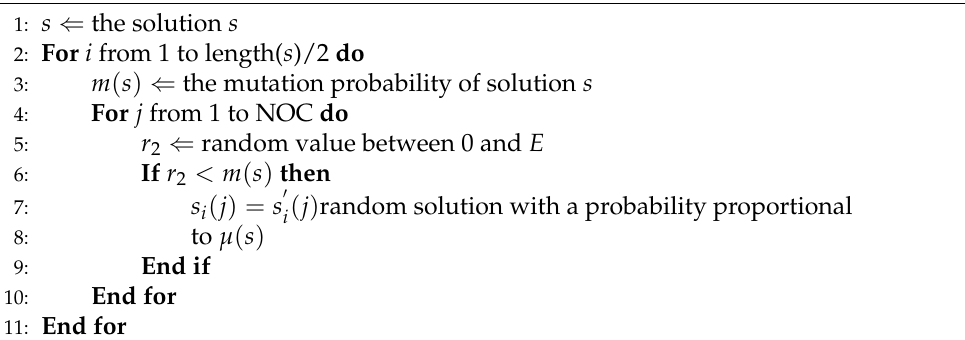
Figure 2. The relationship between P s and HSI. Algorithm 2 The pseudo-code of the migration